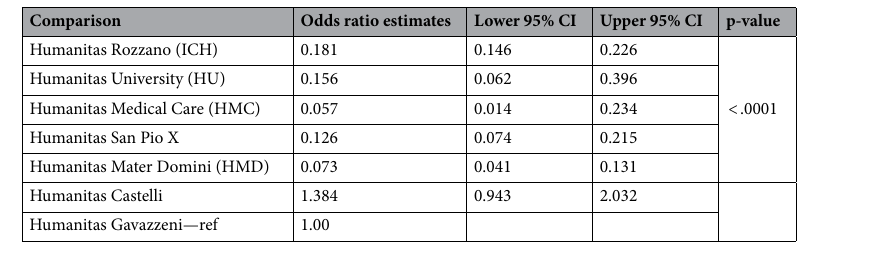
Table 1. Logistic analysis for geographical location of healthcare